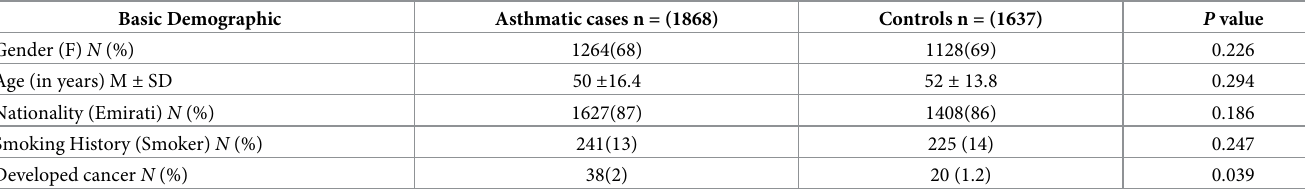
Table 1. Characteristics and comorbidities for asthmatic and control patients during 2010–2018.